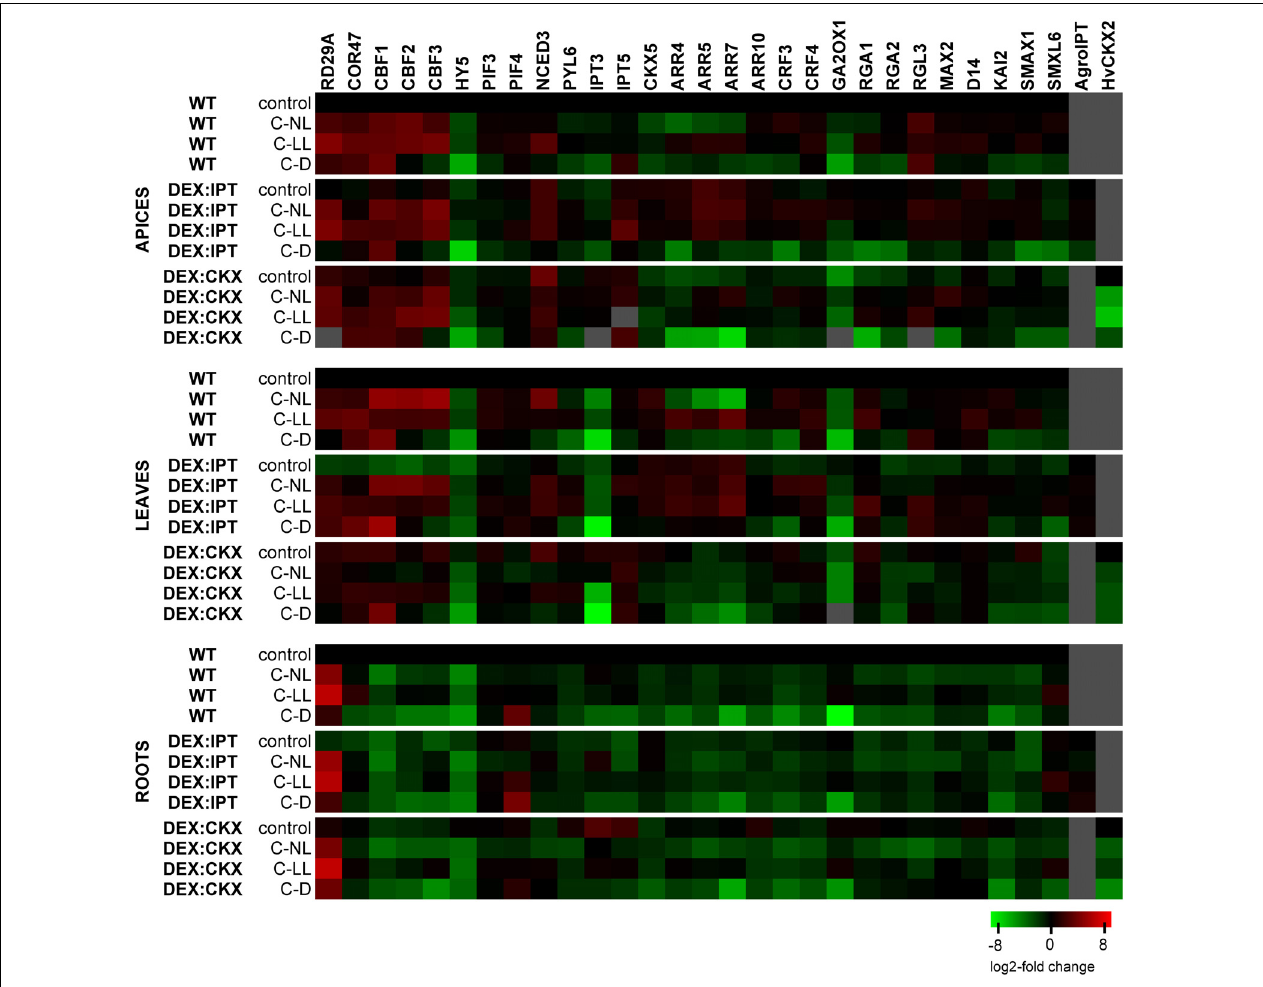
FIGURE 6 | The transcription changes of selected genes related to WT in control conditions within each tissue separately. Means ± SD and detailed statistics of gene transcription are shown in Supplementary Table 3 . Gray squares indicate the transcription level to be below the detection limit. The expression of the transgenes was activated by dexamethasone